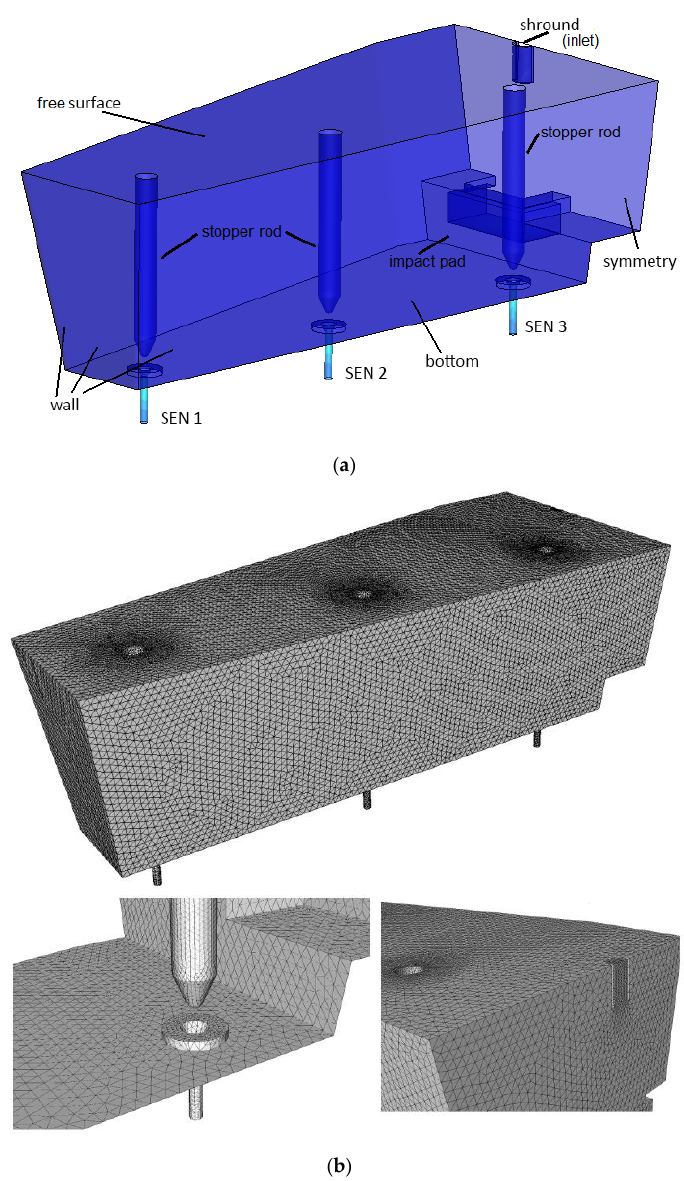
Figure 11. Investigated tundish with ( a ) boundary conditions and ( b ) mesh used for the simulations. Newton’s model is the most well-known, basic model used to calculate the value of the viscosity coefficient of liquids, both ideal—showing the invariability of the value of the dynamic viscosity coefficient under varying shear stress conditions—and non-Newtonian—showing non-linear dependence between shear rate and shear stress.